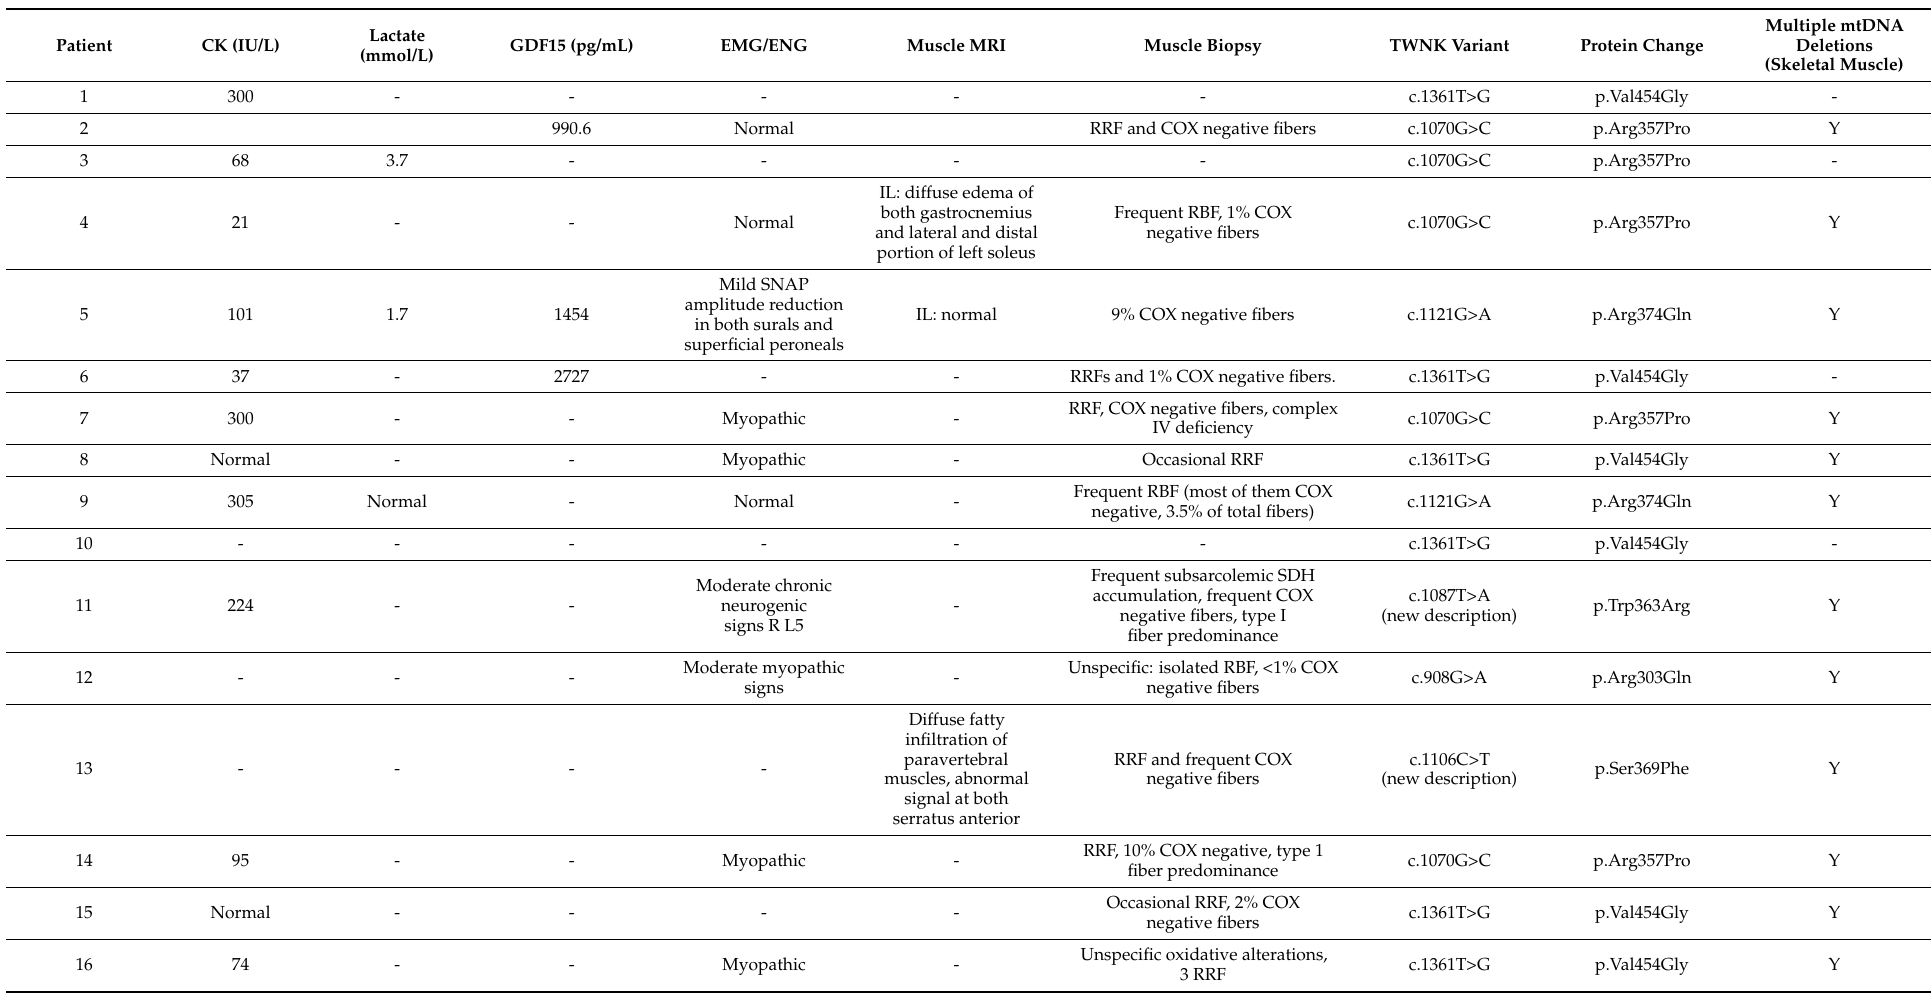
Table 2. Complementary